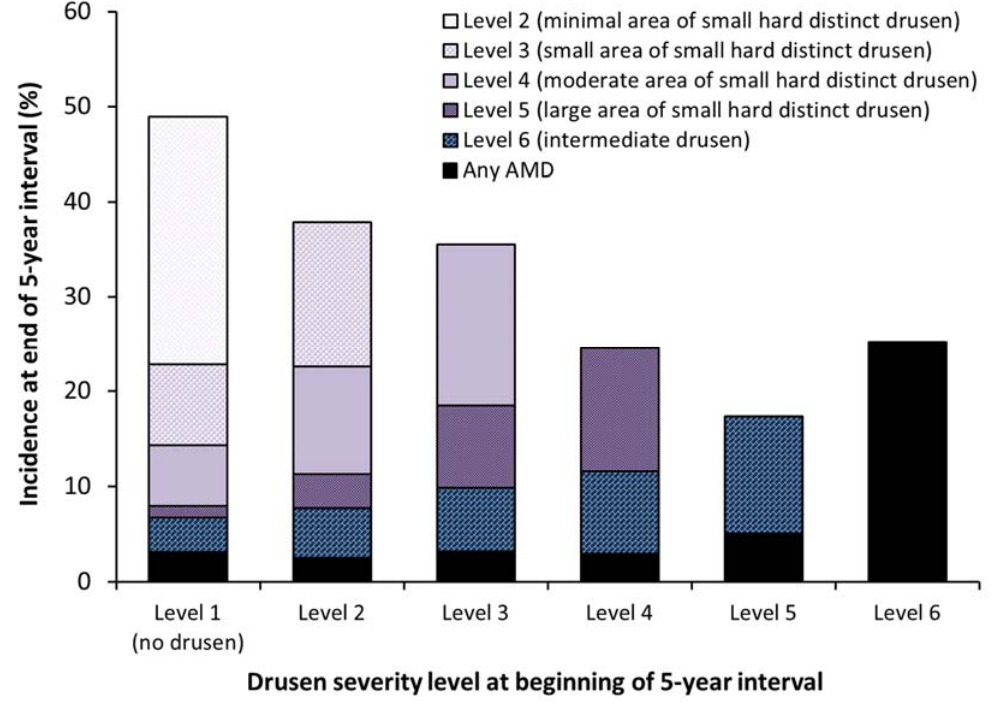
Figure 1. The relationship of no drusen, 4 areas of increasing involvement of the macula by small hard drusen and intermediate drusen to the 5-year incidence of more severe